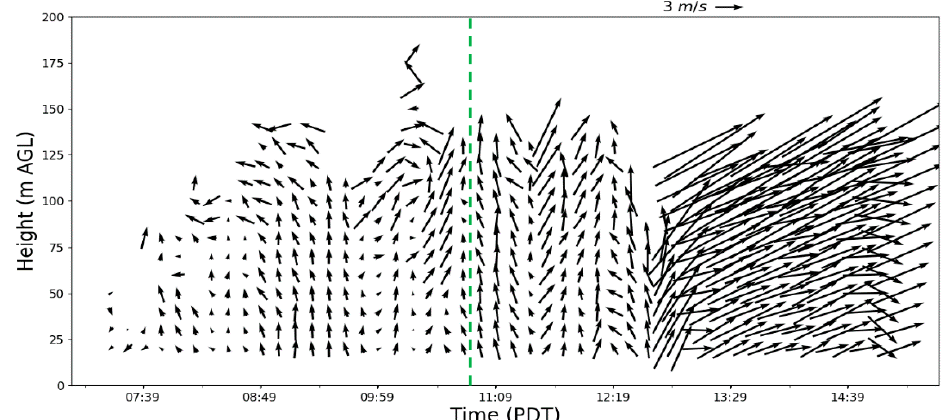
Figure 6. Time–height plot of vertical profile of winds measured from Doppler sodar located near the burn plot boundary (Figure 1). The time of ignition is indicated by the dashed green line.